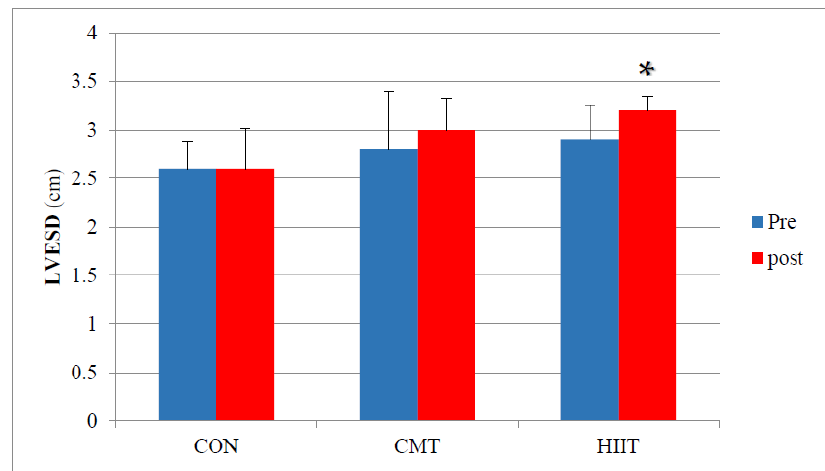
Figure 5. Mean ESD Changes (cm) before and after 12 Weeks of CMT and HIIT; * Indicates a significant increase compared with the HIIT and control groups ( p < 0.05). LVESD: Left Ventricle End-Systolic Diameter (cm). CON: Control. CMT: Continuous Moderate Training. HIIT: High-Intensity Interval Training.